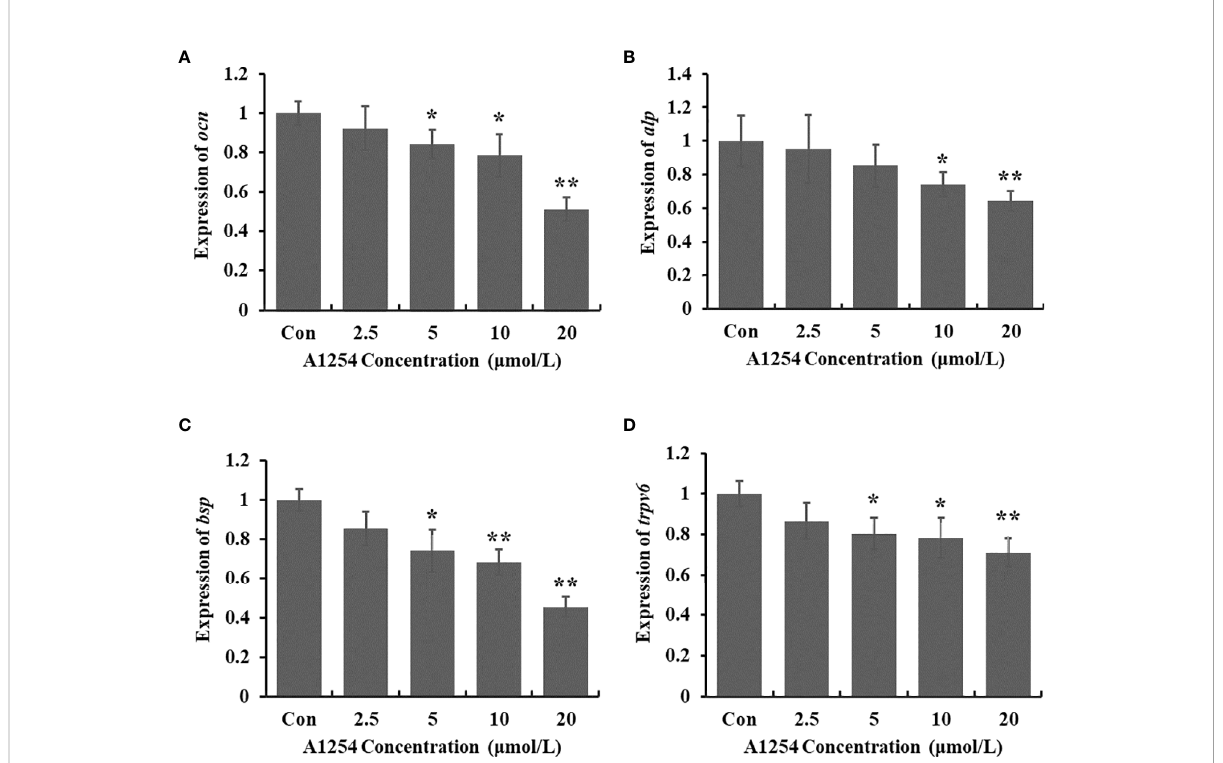
FIGURE 5 The expression of bone turnover markers impaired by A1254 exposure. MC3T3-E1 cells were incubated with various doses of A1254 for 12h, and expressions of (A) ocn , (B) alp , (C) bsp and (D) trpv6 were analyzed with RT-qPCR. Fold changes of gene expression was calculated using the 2- DD Ct method, with Gapdh as an internal reference. *p<0.05, **p<0.01 compared to the